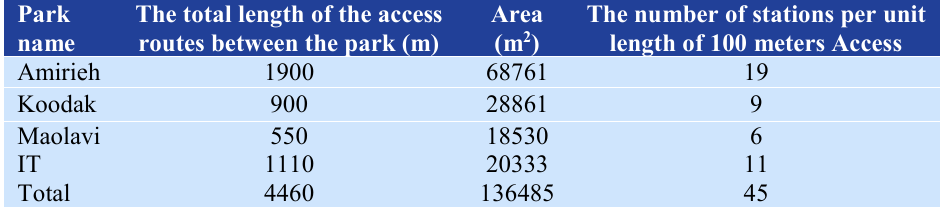
Table 1. Number of measuring stations allocated for each park